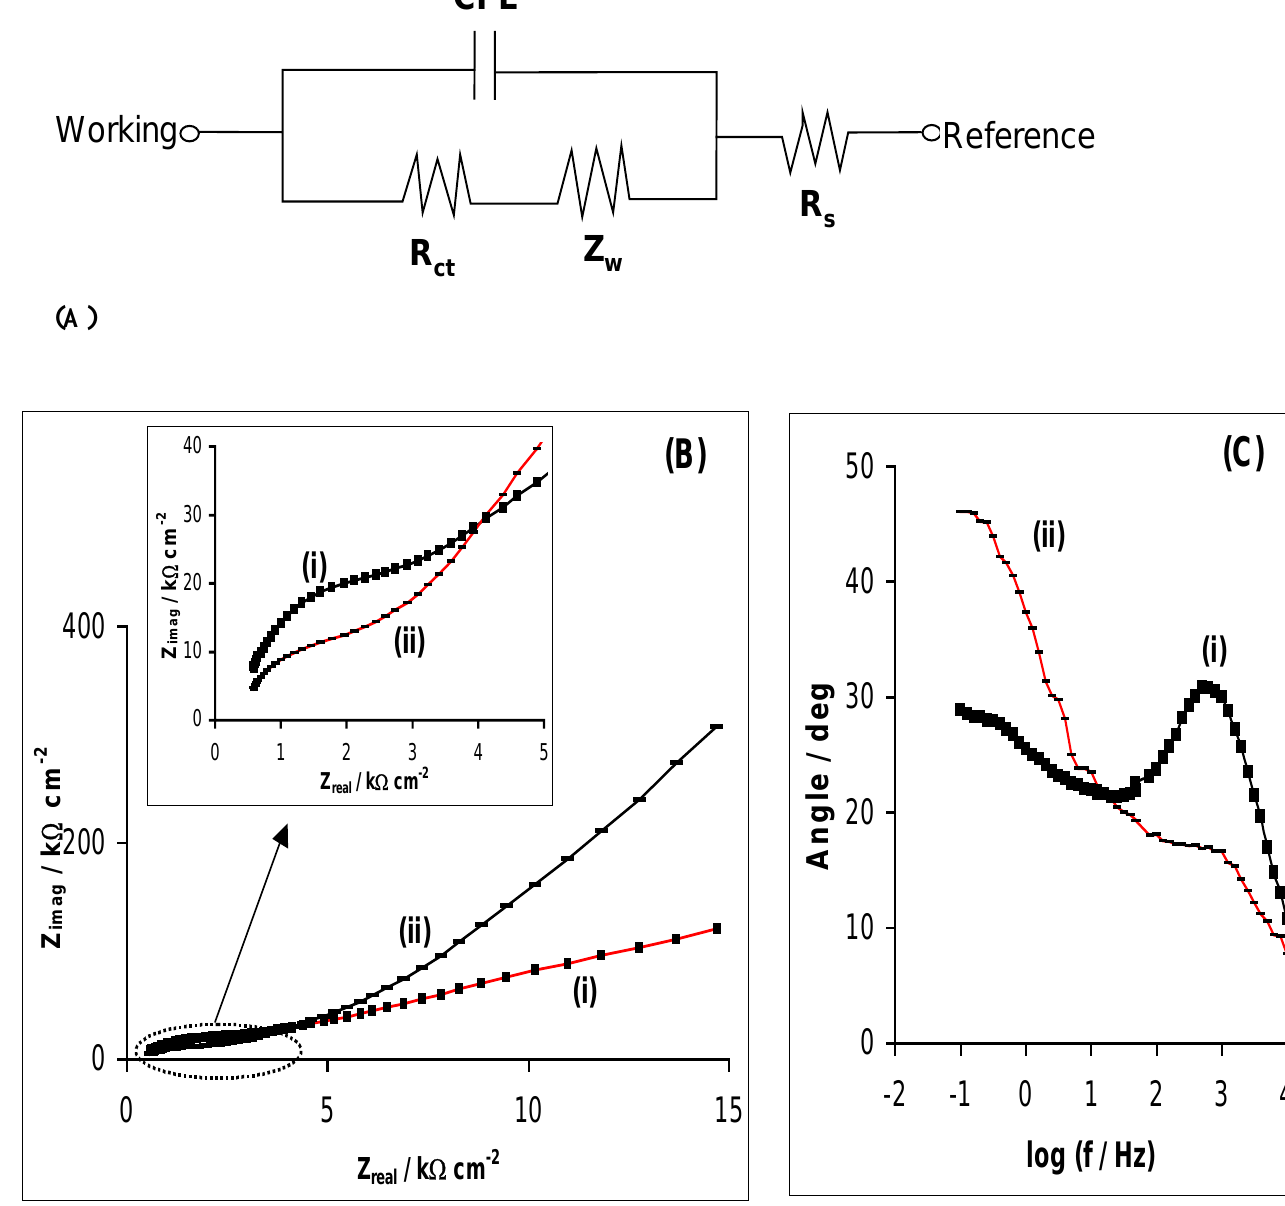
, R , CPE and Z represent the solution s ct w in 0.1M 4 Fe(CN) and K Fe(CN) . 4 6 3 6